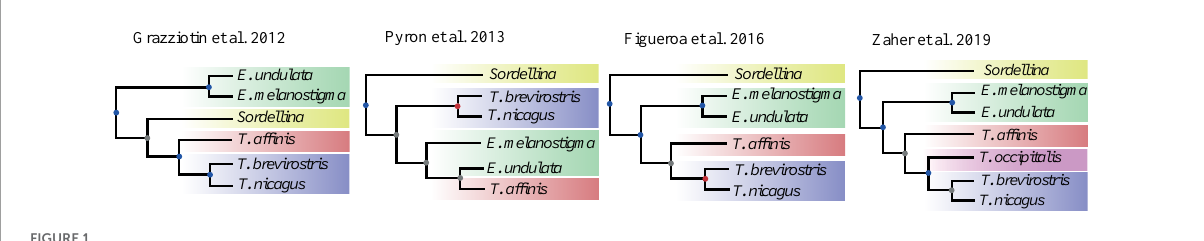
FIGURE1 Comparison between previous topologies on Echinantherini systematics, showing the state of flux on genus-level relationships. Colored circles on each node correspond to bootstrap support values: red (100%), blue (70–99%), and gray ( <